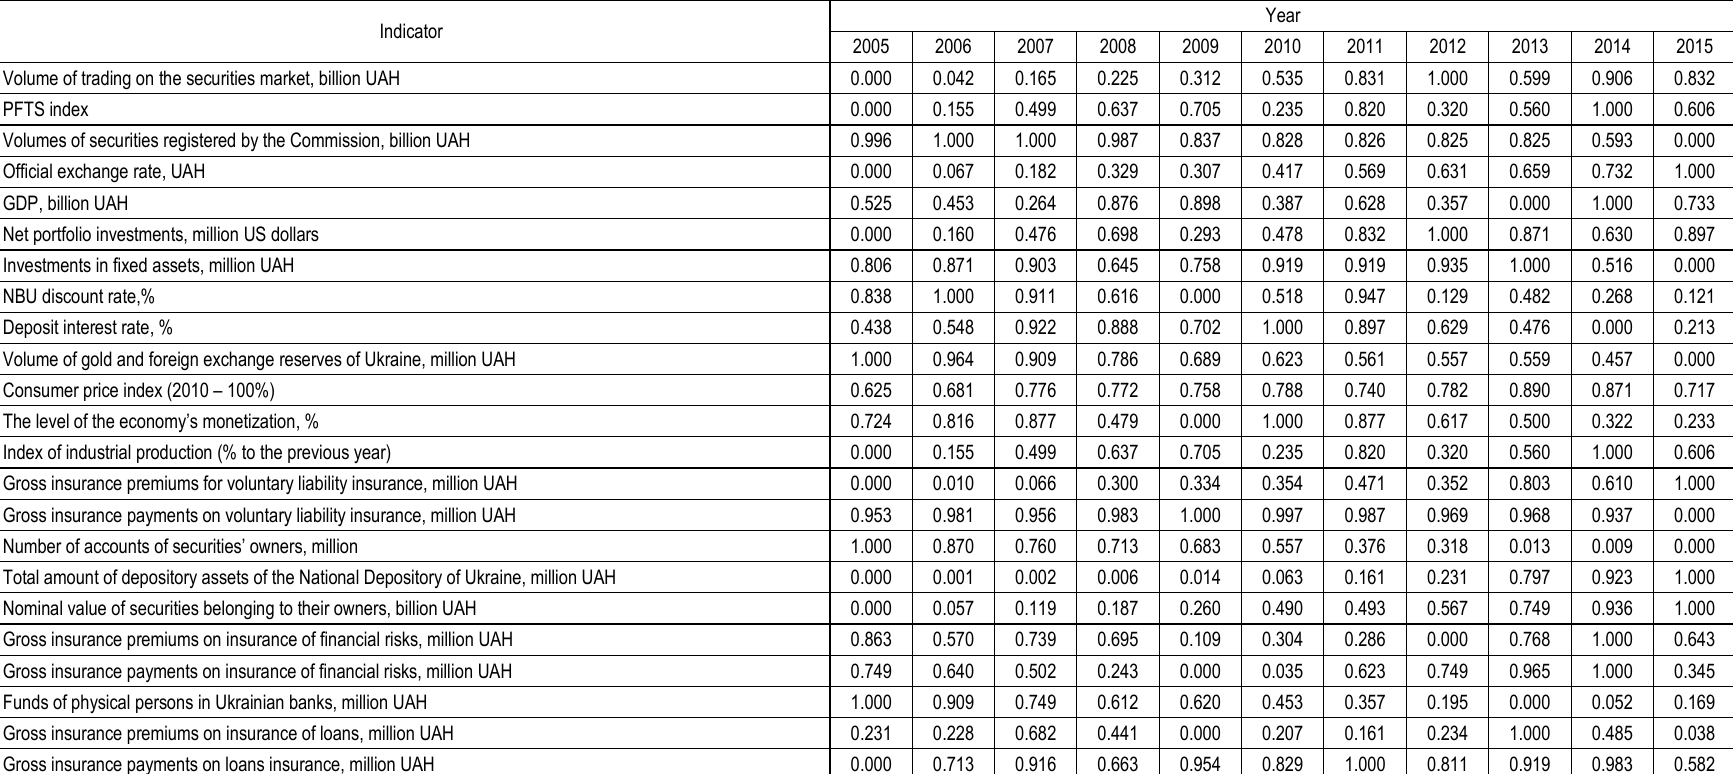
Table B.1. The results of normalization of the input data array